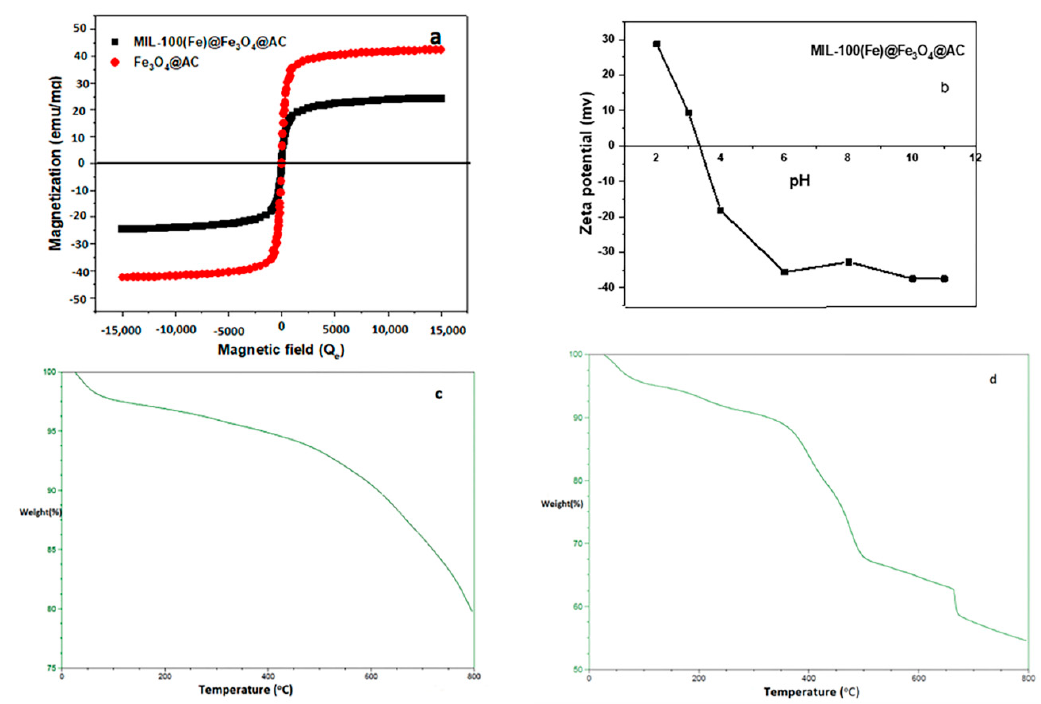
Figure 5. ( a ) Magnetization curves of Fe 3 O 4 @AC and MIL-100(Fe) @Fe 3 O 4 @AC, ( b ) Zeta potential trend of MIL-100(Fe) @Fe 3 O 4 @AC as a function of pH, TGA of ( c ) Fe 3 O 4 @AC, ( d ) MIL-100(Fe) @Fe 3 O 4 @AC. The FT-IR spectra of Fe 3 O 4 @AC, MIL-100(Fe) @Fe 3 O 4 @AC, RhB loaded on MIL-100(Fe)